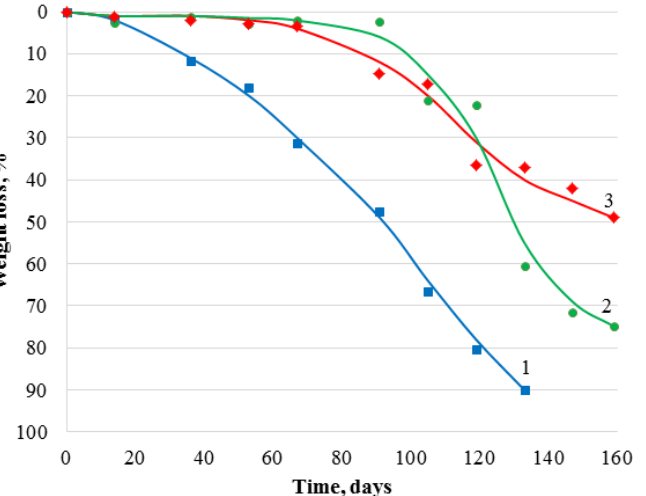
Figure 6. Weight loss of chitosan films under soil degradation conditions: 1-unmodified; 2-modified with poly(GMA-co-DMA); 3-modified with poly(GMA-co-LMA).